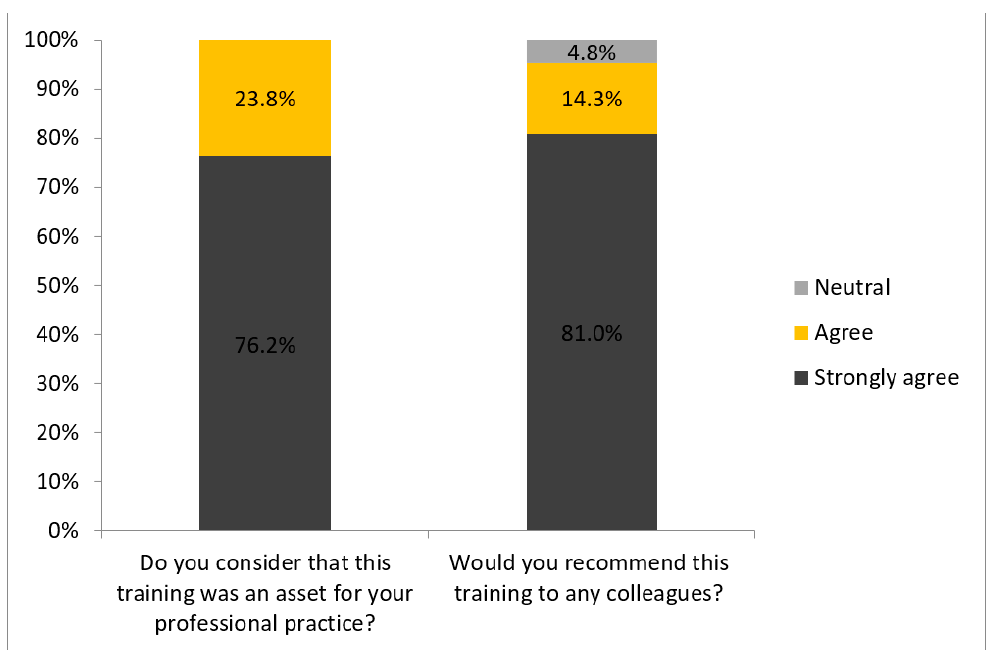
Figure 2. Trainees’ evaluation of the “Health in Equality” program.